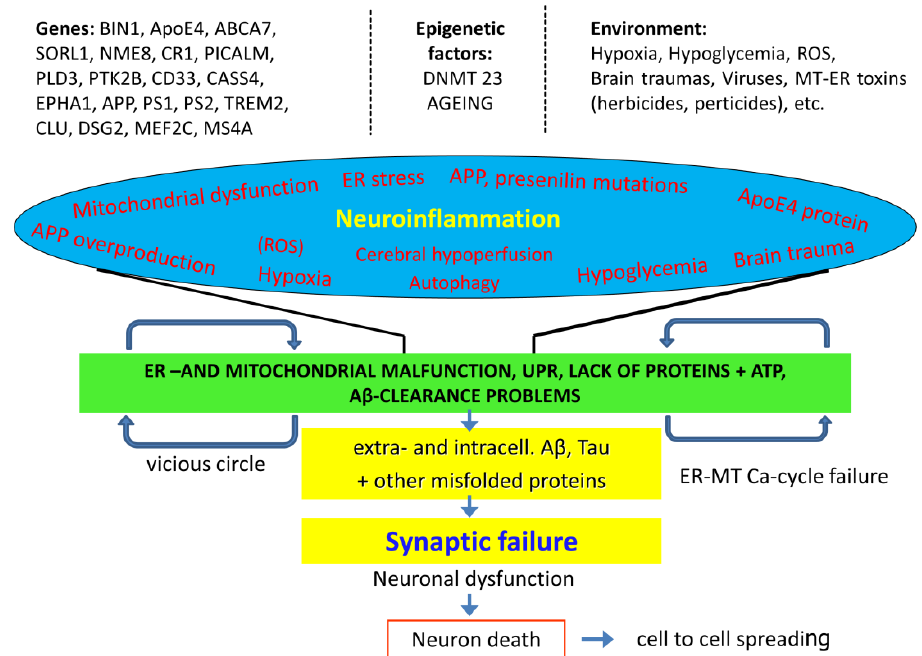
Figure 4. Genes of high and low penetrance, as well as epigenetic and environmental factors are participating in AD pathogenesis. Brain traumas, vascular problems (cerebral hypoperfusion, hypoxia, hypoglycemia), declining amyloid degradation and clearance with aging are involved in ER- and mitochondrial dysfunction and protein dyshomeostasis. Amyloid accumulation leads to neuroinflammation, synaptic failure, neuronal dysfunction and death.